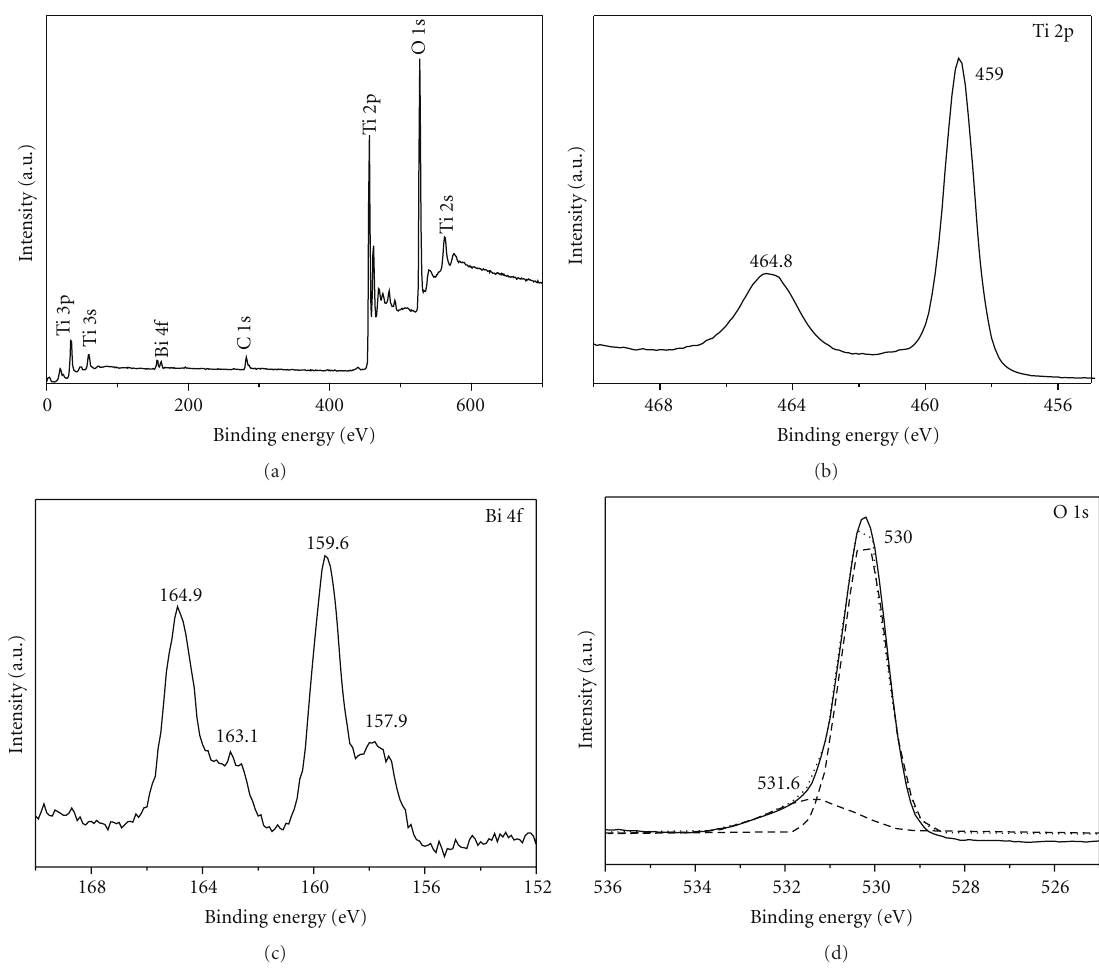
Figure 4: (a) XPS survey spectrum of TBi2, (b) high-resolution XPS spectrum of Ti 2p region, (c) high-resolution XPS spectrum of Bi 4f region, and (d) high-resolution XPS spectrum of O1s region of TBi2.